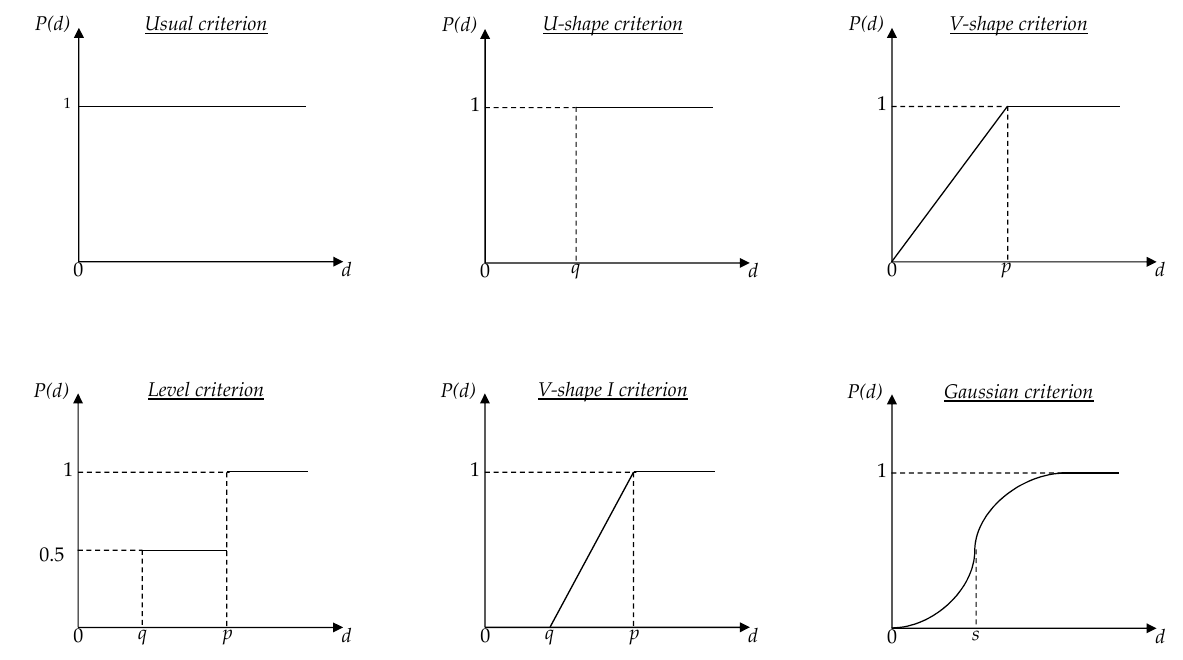
Figure 2. Six types of preference functions, adapted from [43].